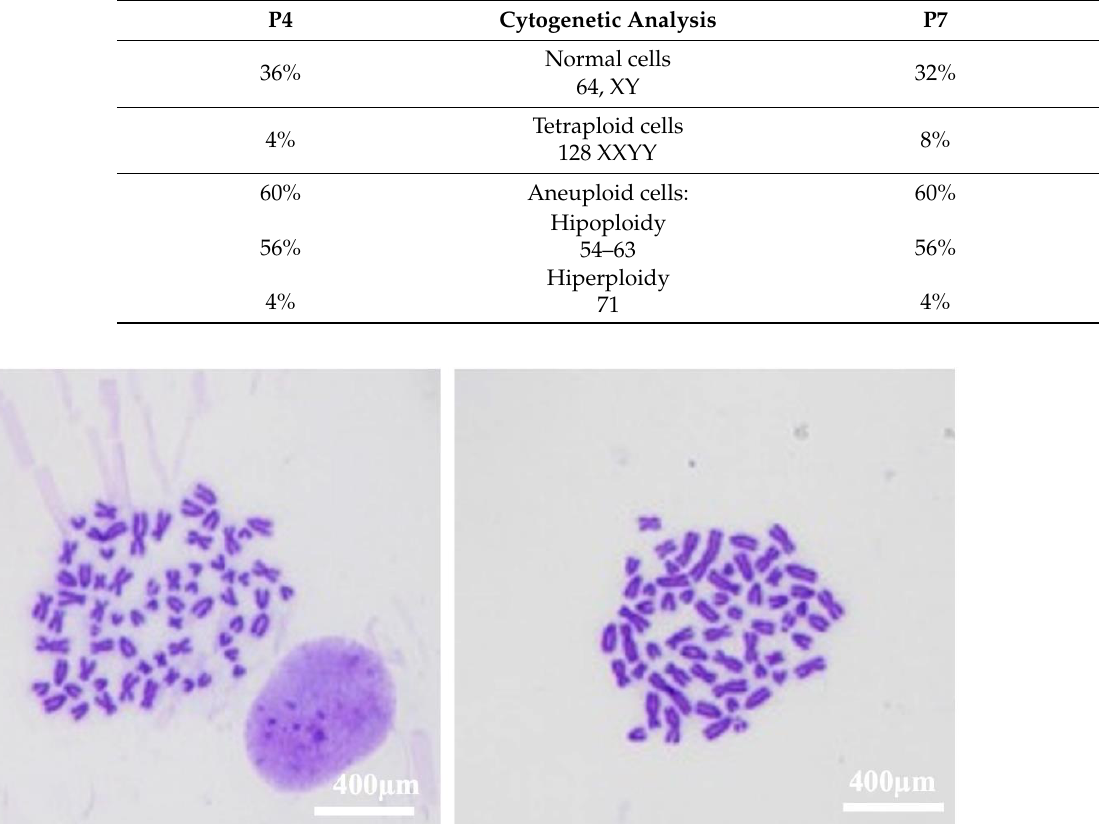
14 of 30 Figure 5. Tri-lineage differentiation: ( a ) eSM- MSC’s adipogenic differentiation, cytoplasmatic lipid vacuoles stained in red (Oil red staining); ( b ) eSM- MSC’s chondrogenic differentiation, proteogly- cans in extracellular matrix stained in blue (Alcian blue staining); ( c ) eSM- MSC’s osteogenic differ- entiation, extracellular calcium deposits stained in red (alizarin red staining). Magnification 100×.